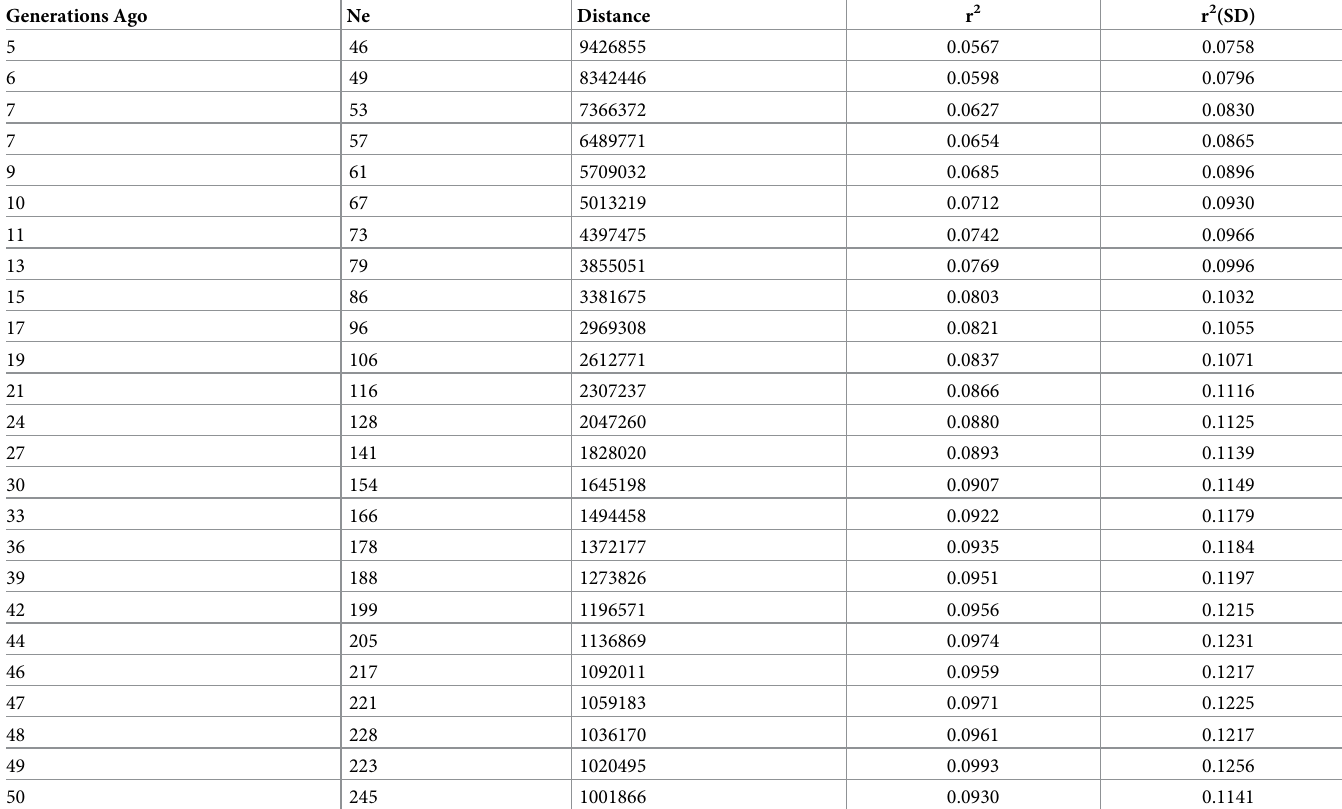
Table 2. Effective population size (Ne) over generations based on linkage disequilibrium calculations. Generations Ago